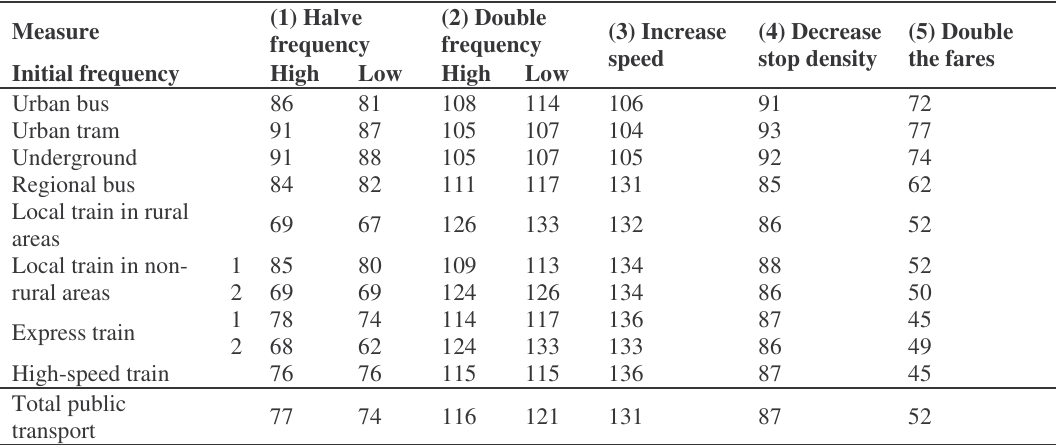
Table 6. Effects of some measures on public transport demand (no measure = 100)